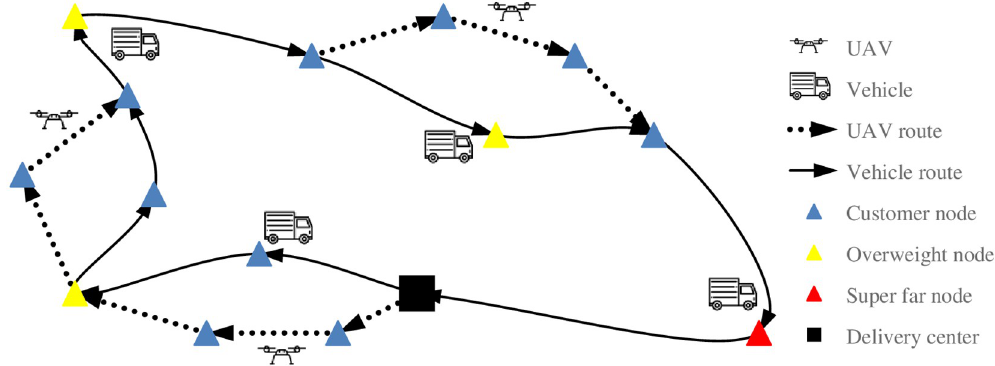
Fig 1. Joint delivery of single UAV and single